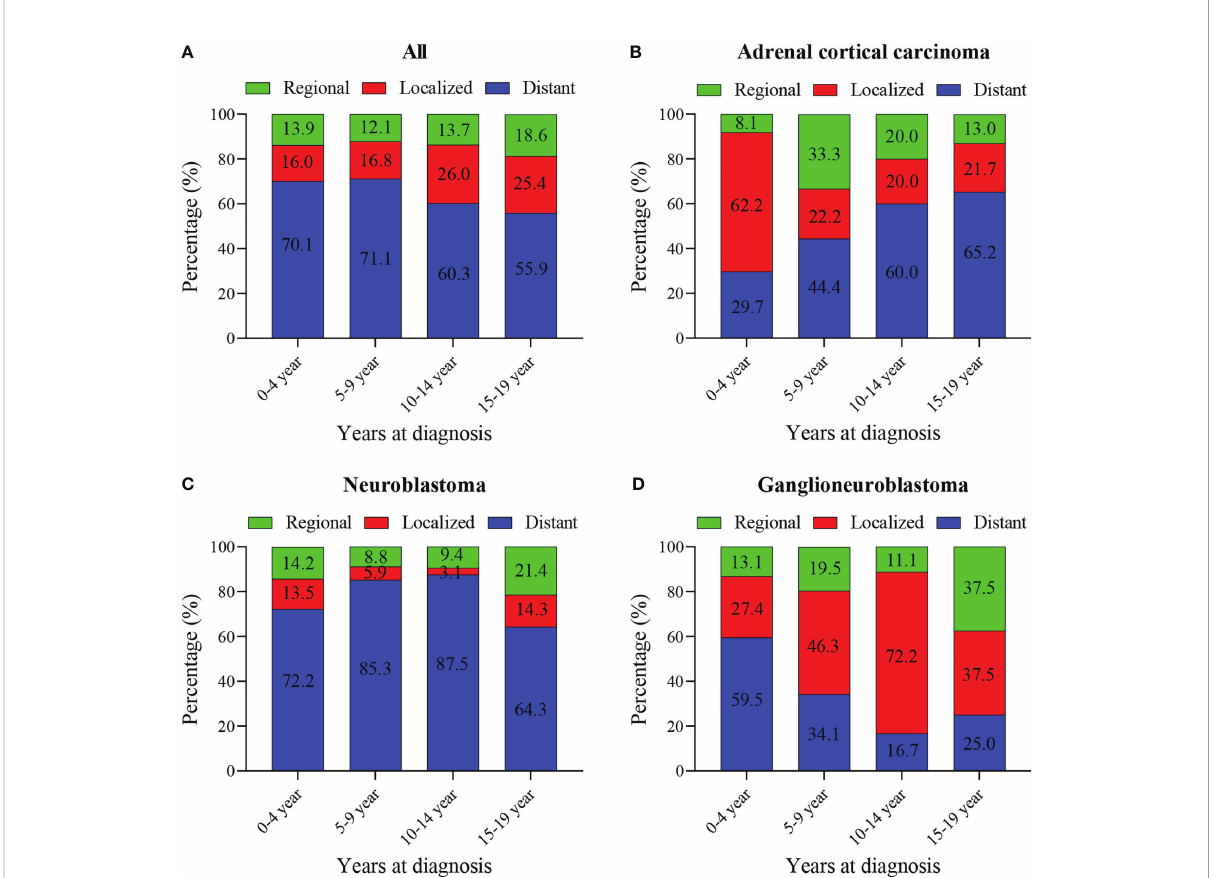
FIGURE 2 Percentage of pediatric adrenal malignancies by age at diagnosis, tumor stage and histology. (A) Percentage of stage in all cohorts and strati fi ed by age at diagnosis. (B) Percentage of stage in Adrenal cortical carcinoma cohorts and strati fi ed by age at diagnosis. (C) Percentage of stage in neuroblastoma cohorts and strati fi ed by age at diagnosis. (D) Percentage of stage in ganglioneuroblastoma cohorts and strati fi ed by age at